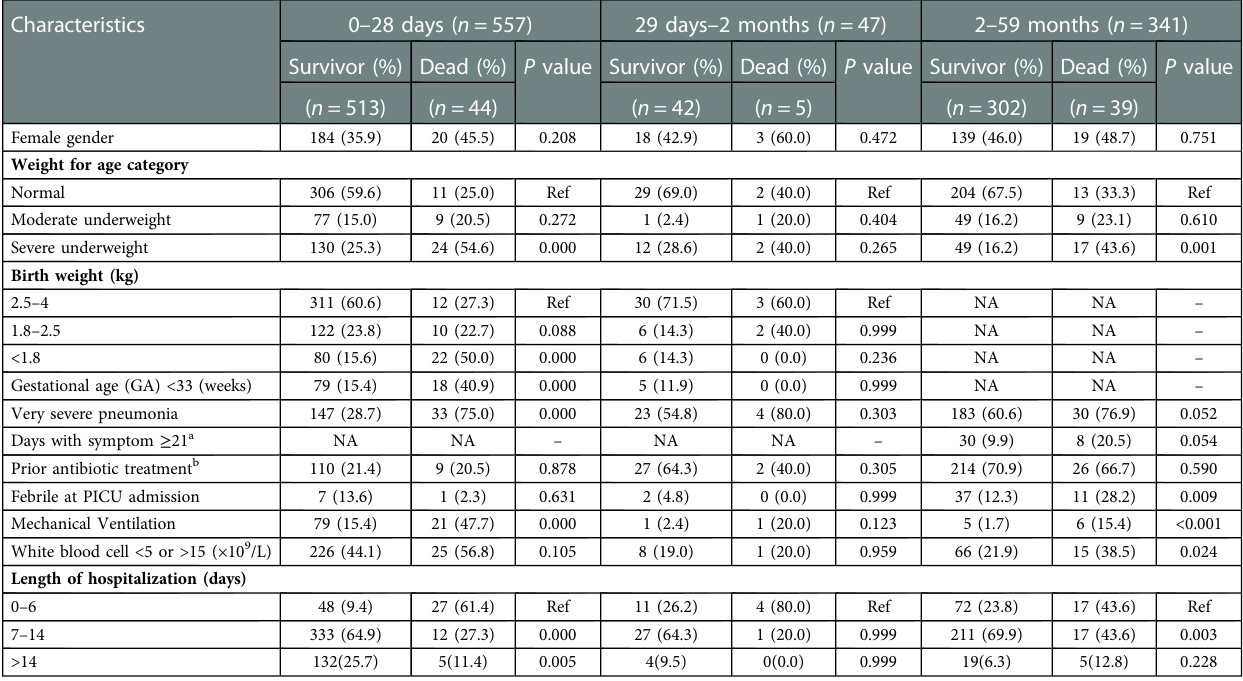
TABLE 1 Characteristics of 945 infants and young children with severe CAP in PICUs.